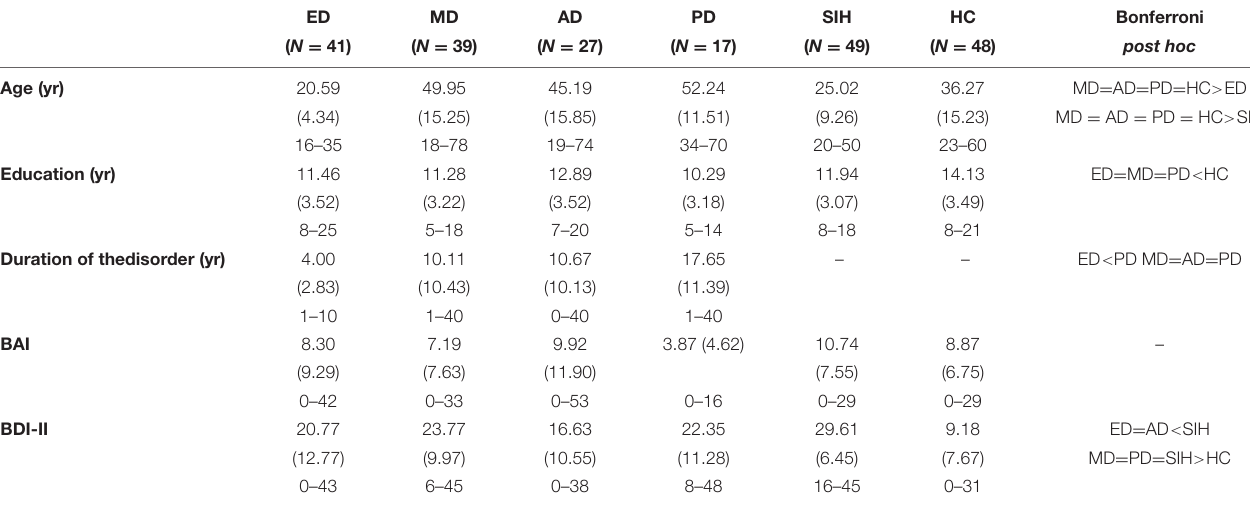
TABLE 1 | Means standard deviations ( SD ) ranges and post hoc comparisons of age, education, duration of the disorder, BAI and BDI-II scores across the groups studied. ED